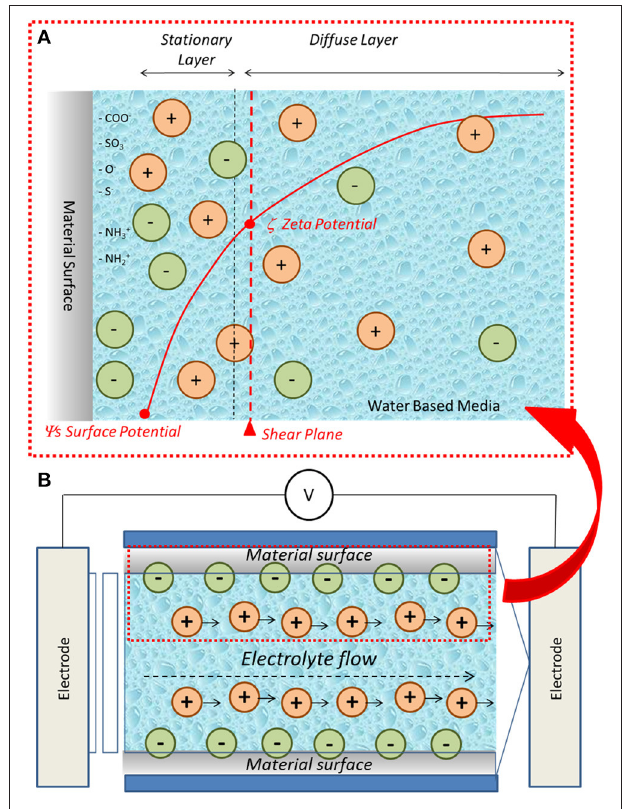
FIGURE 1 | (A) Schematic representation of charge development at biomaterial-water based medium interface and zeta potential, (B) schematic representation of the streaming potential technique for the measurement of solid surface zeta